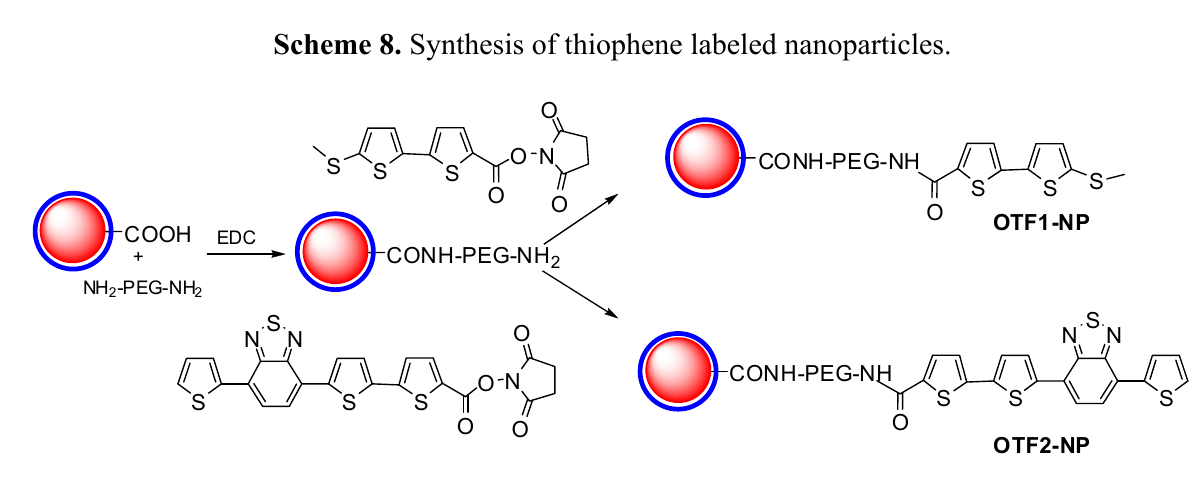
Figure 13. Comparison of the photoluminescence spectra of thiophene fluorophores OTF1 and OTF2 in DMSO with those of the corresponding OTF-NP conjugates. Top panel: OTF1-PEG897-Au and OTF2-PEG897-Au compared with nonconjugated fluorophores OTF1 and OTF2 in DMSO. Bottom panel: OTF1-PEG897-  -Fe compared with nonconjugated OTF1 and OTF2 in